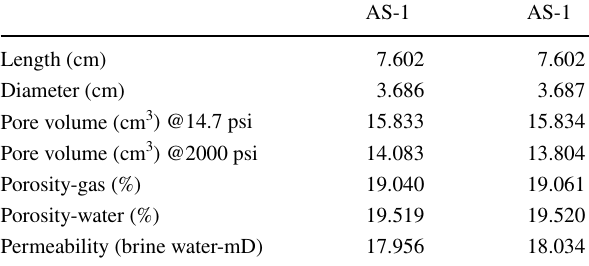
Table 2 Petro-physical properties of the cores